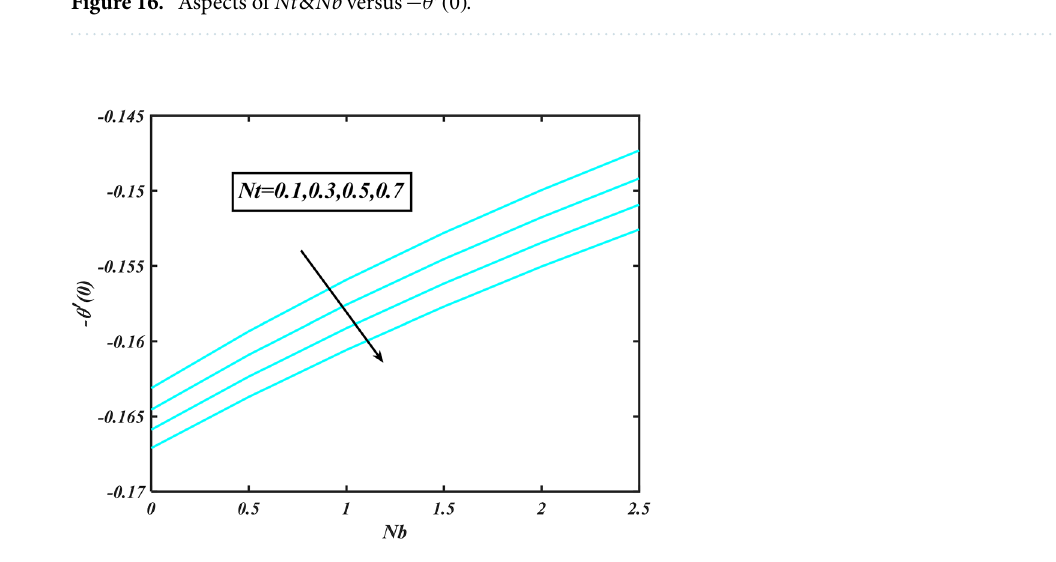
Figure 16. Aspects of Nt & Nb versus − θ ′ ( 0 ) .